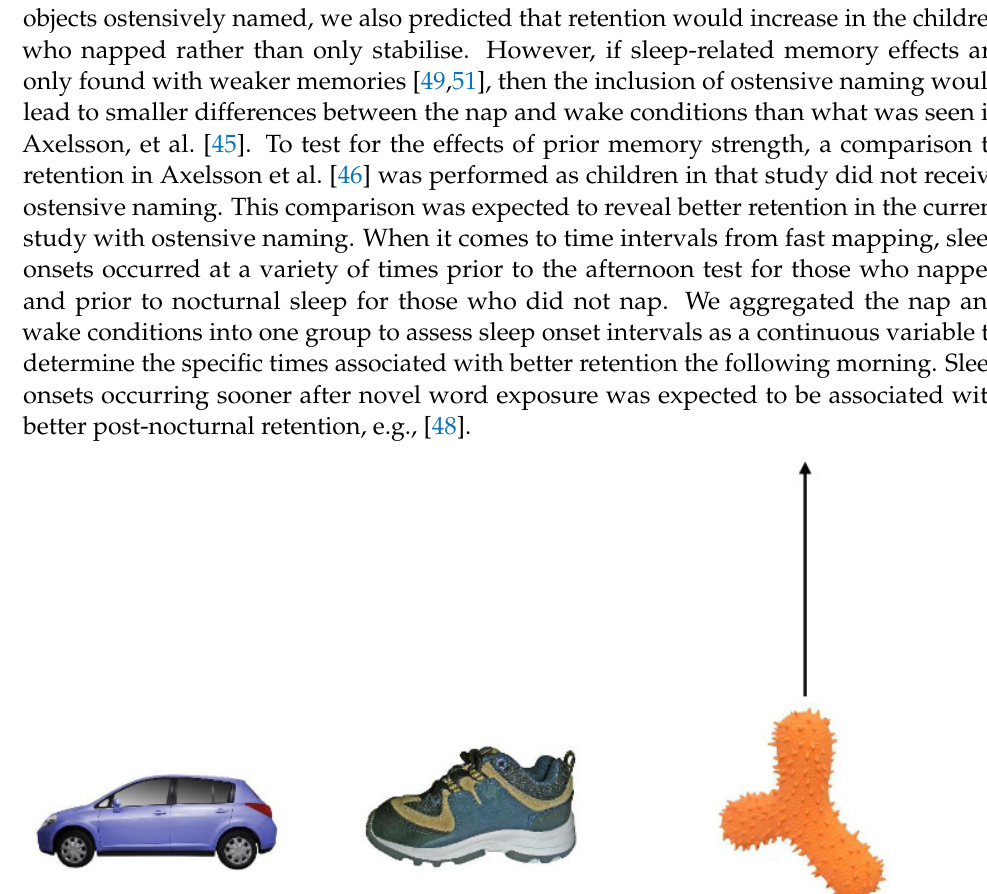
Figure 3. Display Layout in the Retention Tests for the Four Novel Objects. Afternoon and post-nocturnal retention . Delayed retention was tested in the child’s home approximately 4 h later. Within the interval from immediate testing to afternoon,